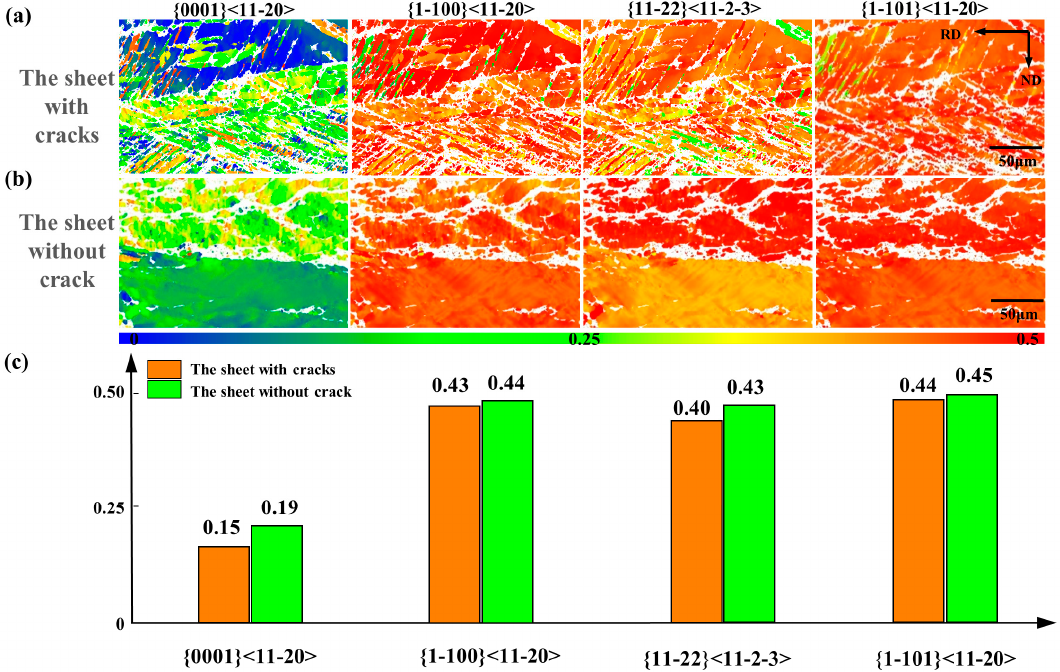
Figure 15. ( a , b ) Schmidt factor distribution and ( c ) average Schmidt factor value of the sheet with cracks and without cracks.